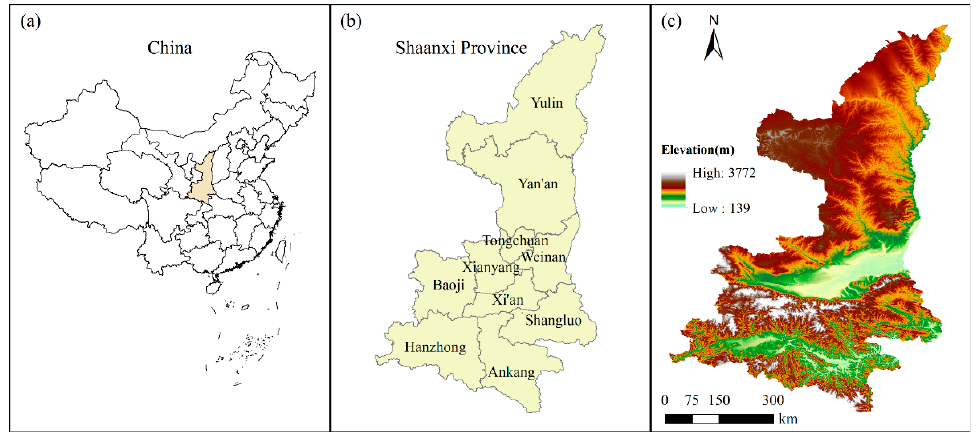
Figure 1. Location of Shaanxi Province, China: ( a ) Map of China; ( b ) 10 prefecture-level cities of Shaanxi Province; ( c ) Digital elevation model (DEM).